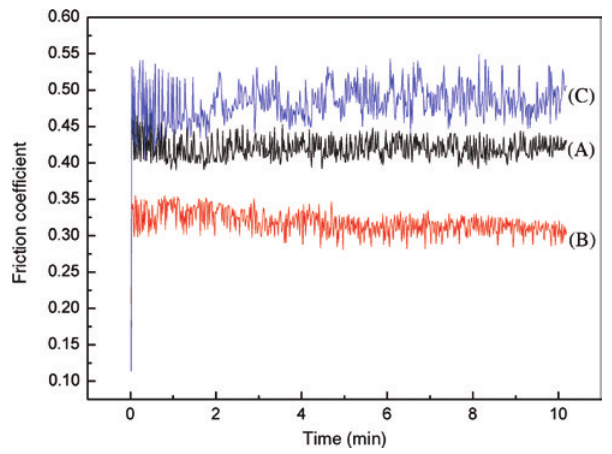
Figure 6: Friction coefficient as a function of time for (A) pure PU coating, (B) 2 wt.% SiO /PU composite coating, and (C) 5 wt.% 2 SiO /PU composite coating. 2